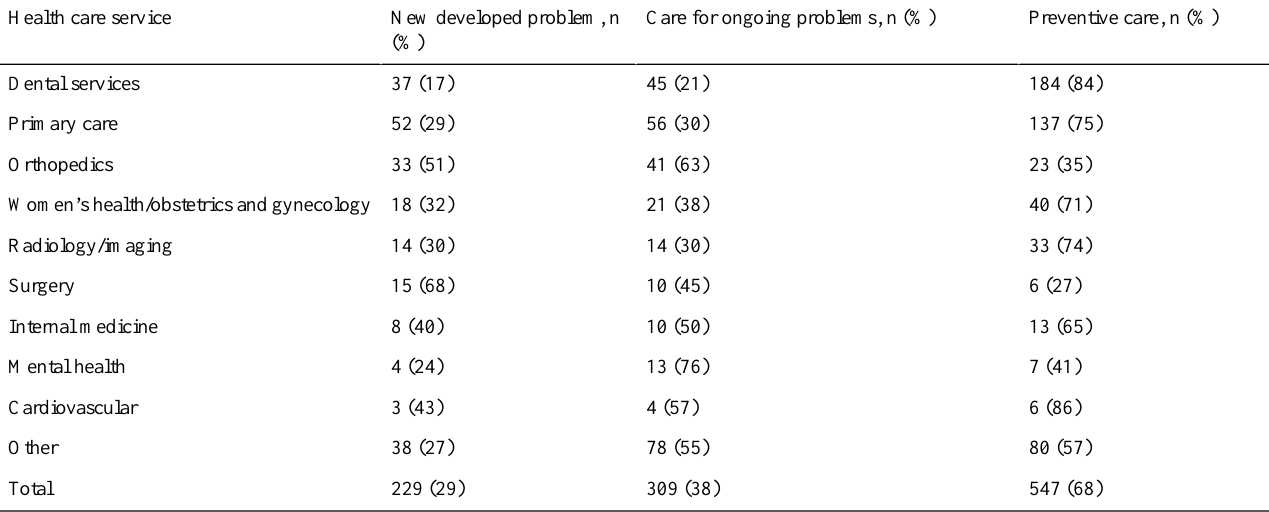
Table 3. Reasons for delayed care, by service line and problem type, among 803 survey respondents in Vermont between April 30 and May 13, 2020, who reported deferring care due to the COVID-19 pandemic medical services